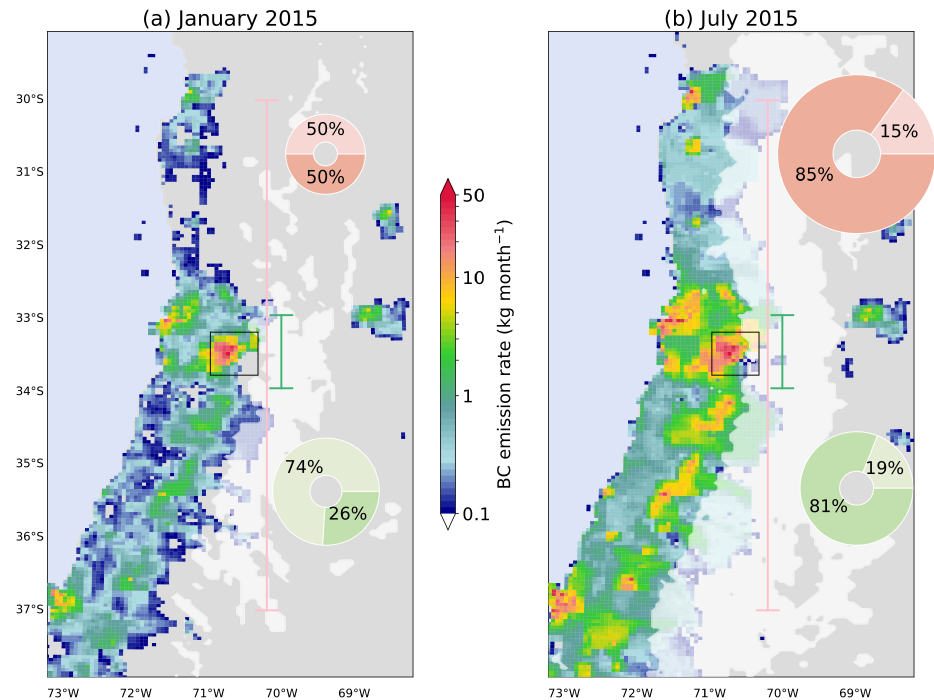
Figure 2. Simulated emissions of BC and accumulated deposition on glaciers of the central Chilean Andes in (a) January and (b) July 2015. Color map shows BC emission rates. The black box represents the Santiago city area. Two different zones are considered: 30–37 ◦ S (pink color code) and 33–34 ◦ S (green color code). Pie charts show the share of deposition attributable to emissions from Santiago (lighter color) and other regions (darker color). Pie chart sizes are proportional to total deposition. The white shaded area corresponds to snow-covered grid points in the